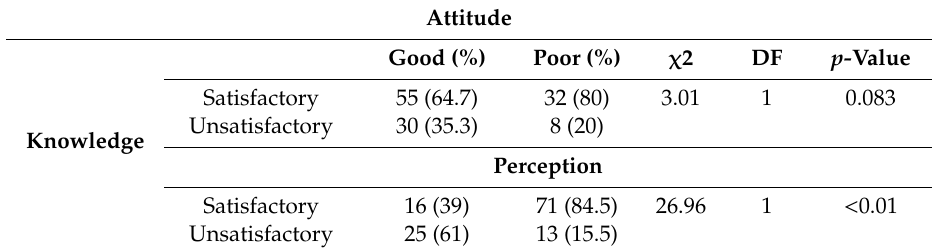
Table 6. Association of knowledge level and the attitude and perceptions of poultry farmers on ABR.